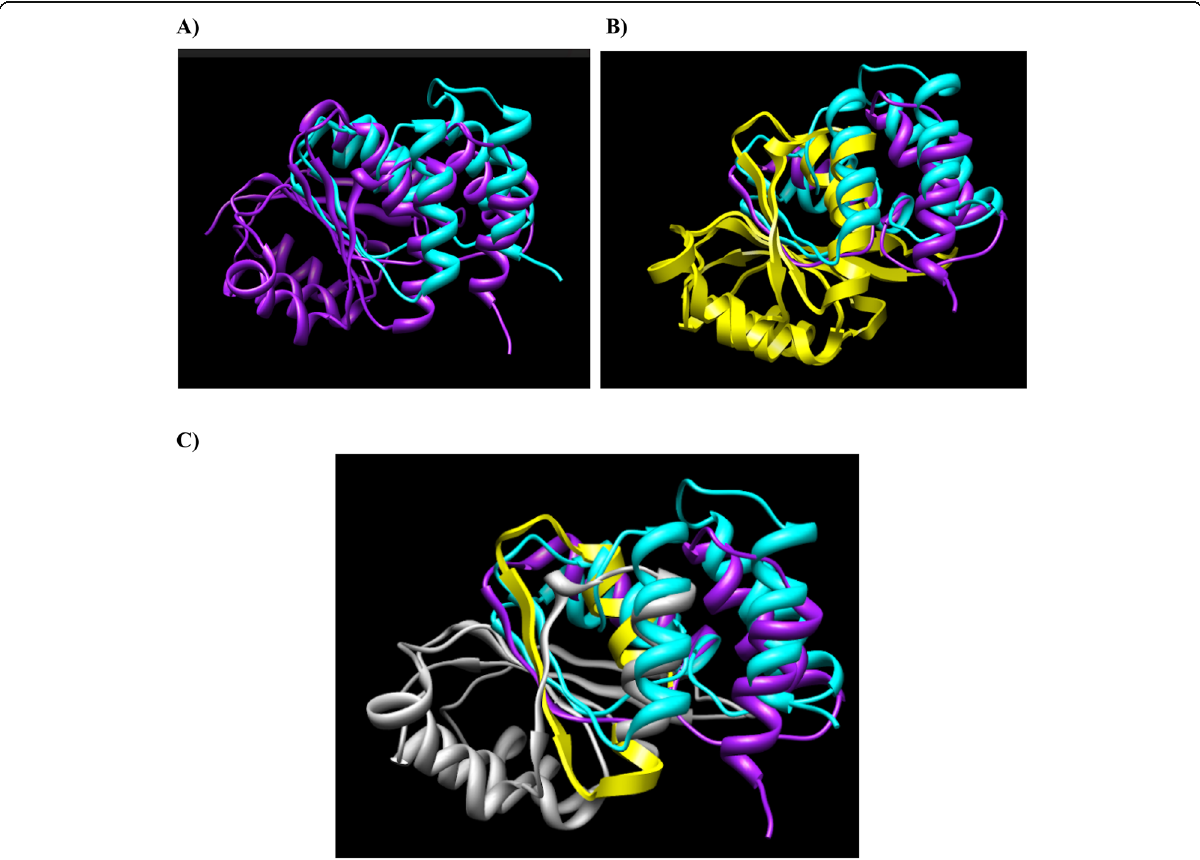
Fig. 2 Protein structure modeling of wild-type and mutated LRTOMT. a the merged image of wild-type LRTOMT is shown in purple and mutanted LRTOMT in cyan. A part of the amino acid sequence has been eliminated in the mutated protein compared to the wild type protein ( b ) the catechol-O-methyltransferase domain, as a functional domain, is shown in yellow and in the figure ( c ) the modified COMT domain in the mutanted protein is defined in gray. The affected amino acids (residue 170 – 291) are a part of catalitic